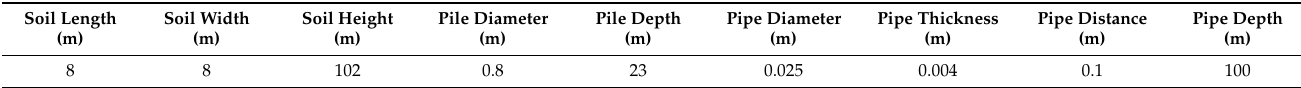
Figure 4. Schematic diagram of the whole model and grid division. ( a ) Overall model diagram; ( b ) overall grid diagram of the model; ( c ) upper grid diagram; ( d ) pile top grid diagram. Table 1. Model size of deep buried pipe energy pile.